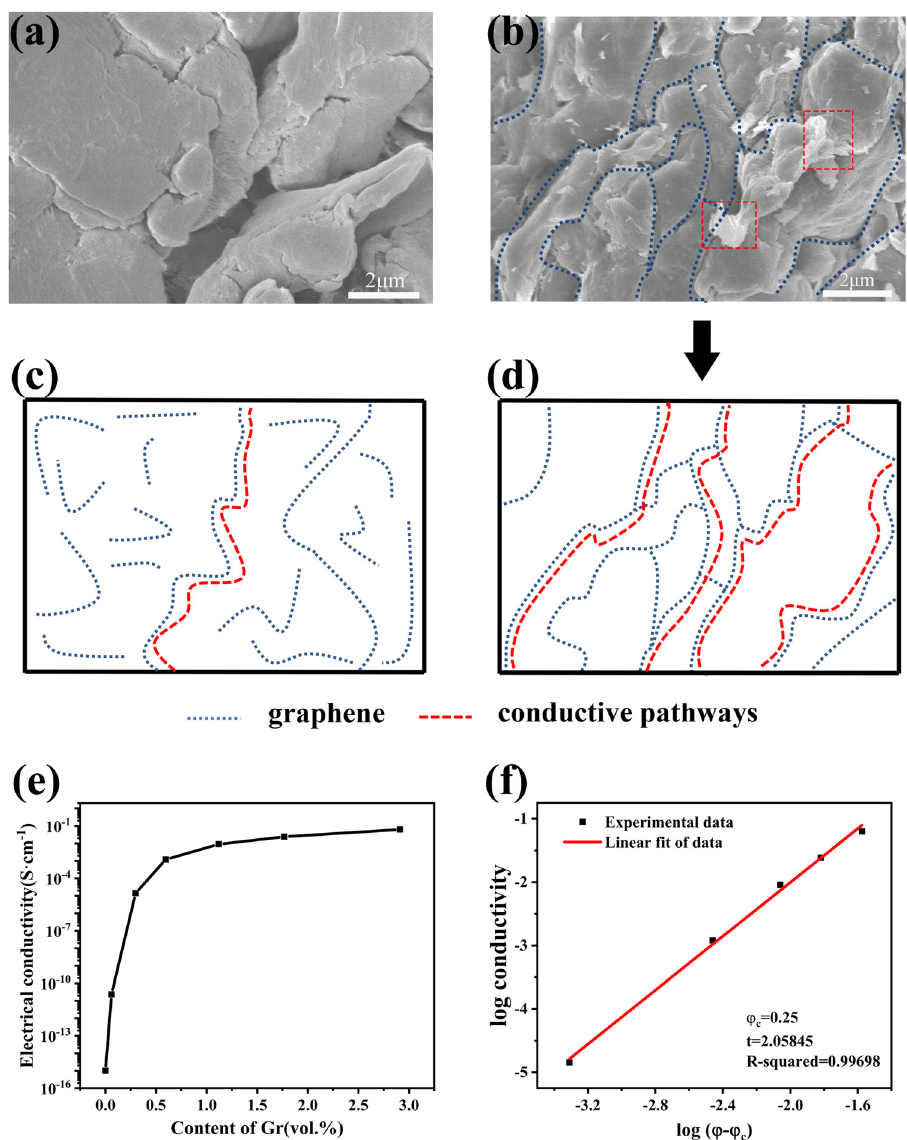
Figure 5: ( a ) SEM images of PEEK - NH 2 and ( b ) PEEK - NH 2 /GN nanocomposites pressed at room temperature, ( c ) schematic illustration of the conductive pathways in substrates for random distribution and ( d ) GN, ( e ) electrical conductivities of PEEK - NH 2 /GN nanocomposites as a function of volume fraction of Gr, and ( f ) double logarithmic curve of conductivity versus ( φ – φ c )